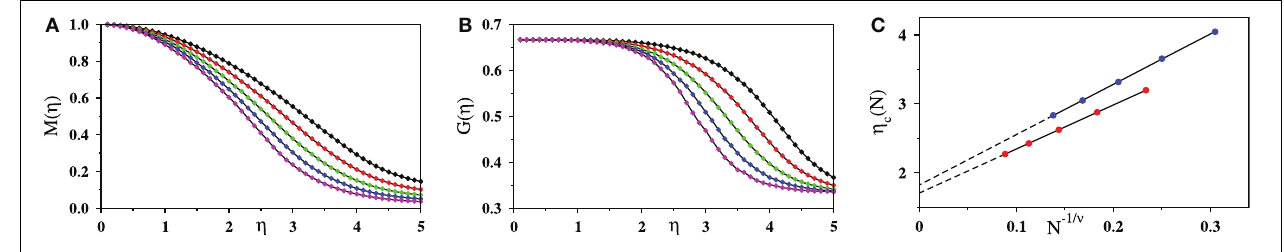
FIGURE 11 | (A) The stationary state order parameter M ( η ) and (B) the Binder cumulant G ( η ) have been plotted for the system sizes N = 64 (black), 128 (red), 256 (green), 512 (blue), and 1024 (magenta) where all agents start with their initial velocities in the